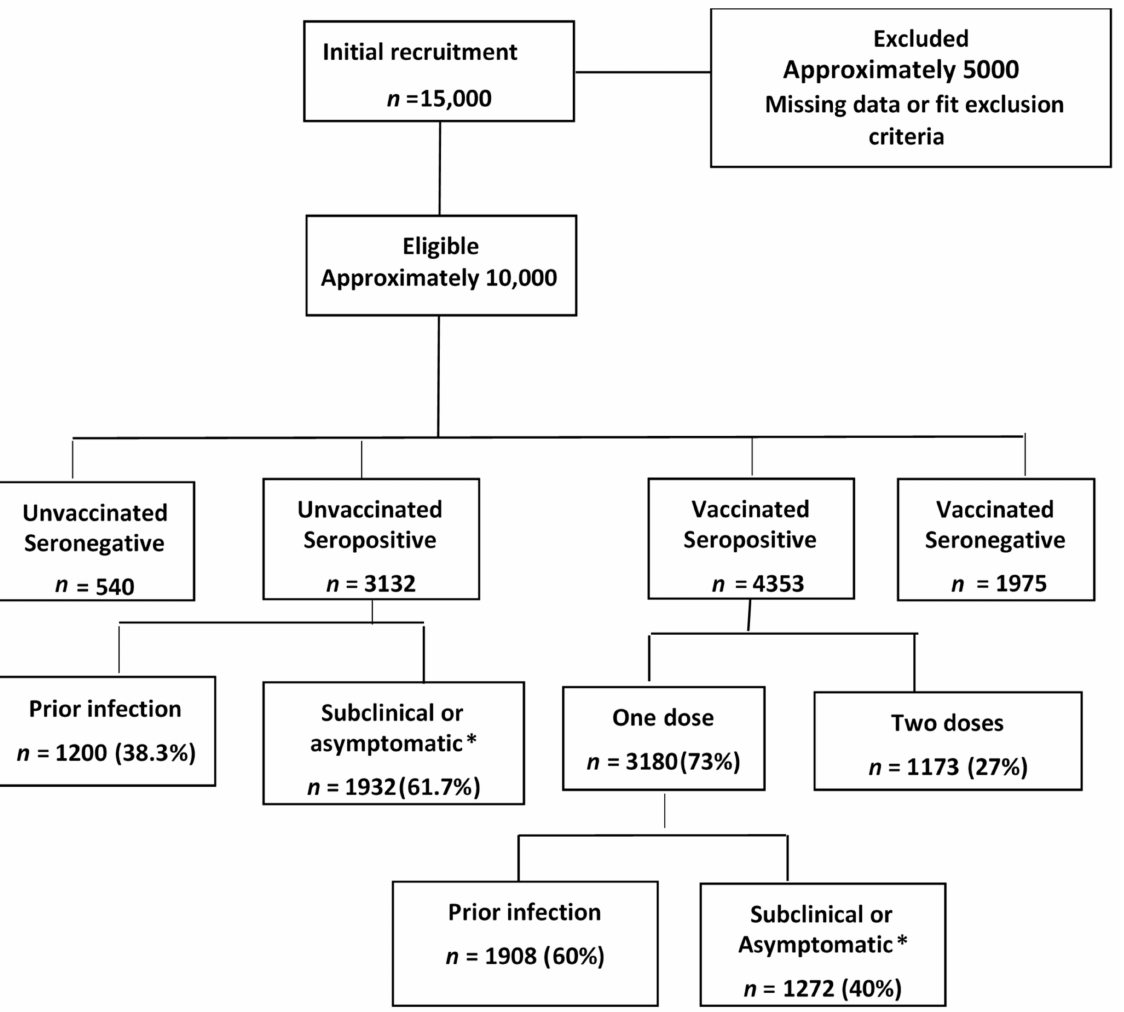
Figure 1. Flowchart showing recruitment and participant selection. The blood specimens were collected at multiple time points following vaccination. The second dose of the vaccine was of the same vaccine type (homologous). n indicates number and * Denotes participants who didn’t report previous infection in the survey but gave positive IgG titer indicating previous undiagnosed SARS-COV-2